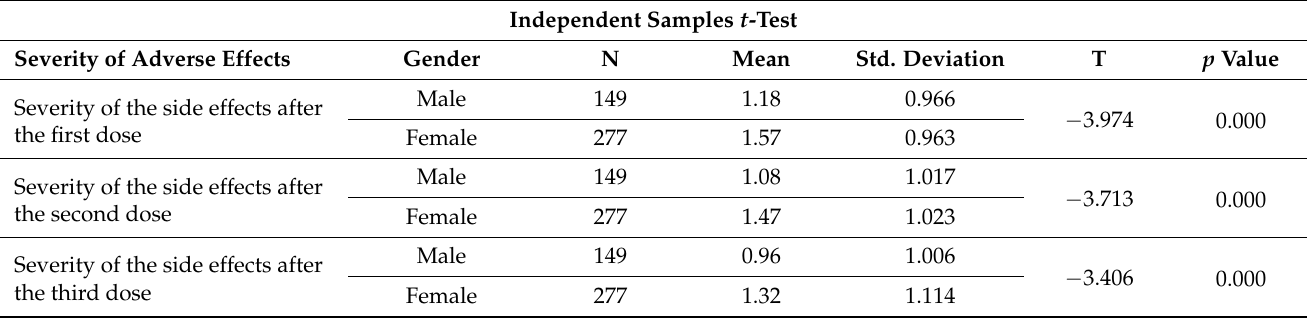
Table 4. Comparison of severity of adverse effects of Pfizer, Oxford–AstraZeneca, and Moderna COVID-19 vaccination between male and females.